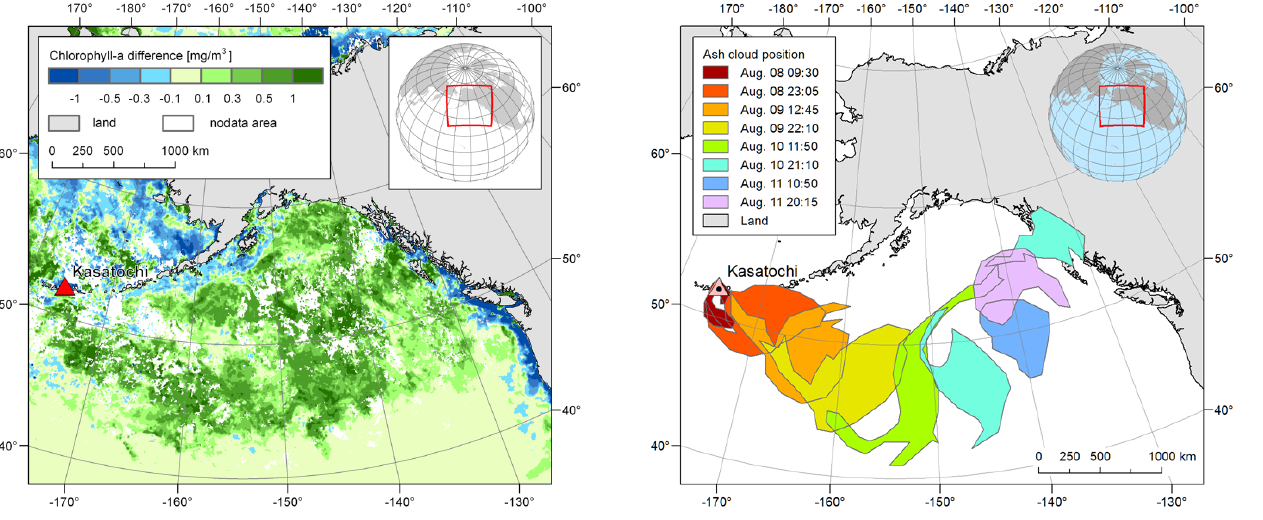
Fig. 2. Atmospheric dispersion of the Kasatochi ash cloud from 8– 11 August 2008 based on MODIS level 1b data at 11 and 12µm using brightness temperature difference (BTD) (from Langmann et al.,